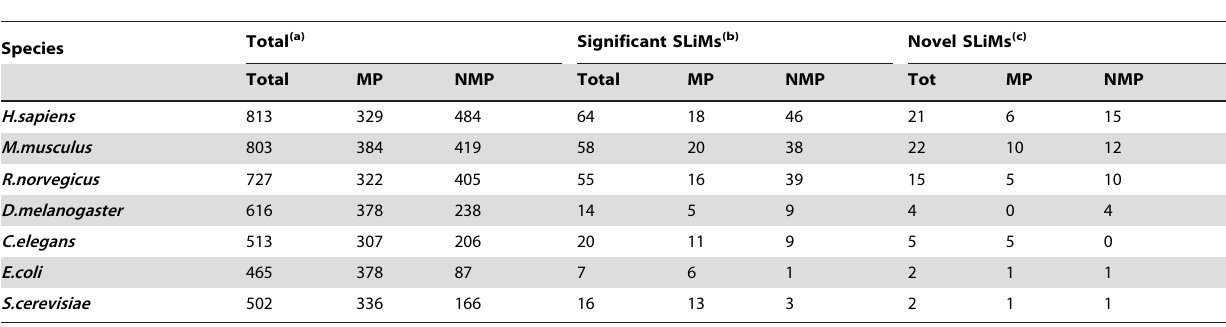
Table 3. Number of motif representatives predicted in KEGG pathways.